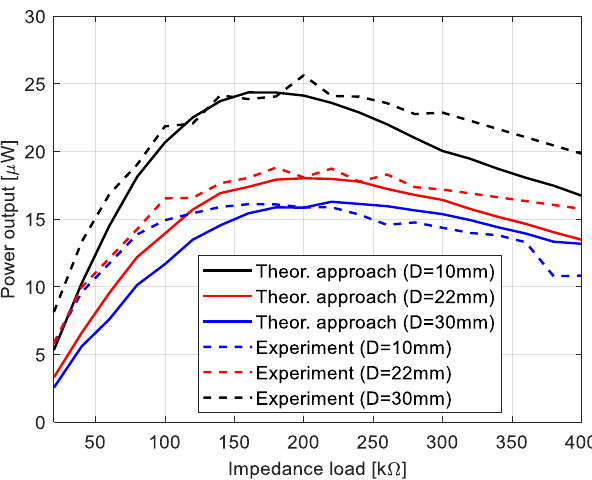
Figure 11. The comparison of a power output from the piezo-harvester located on the top of the structure, generated and calculated from the theoretical model.